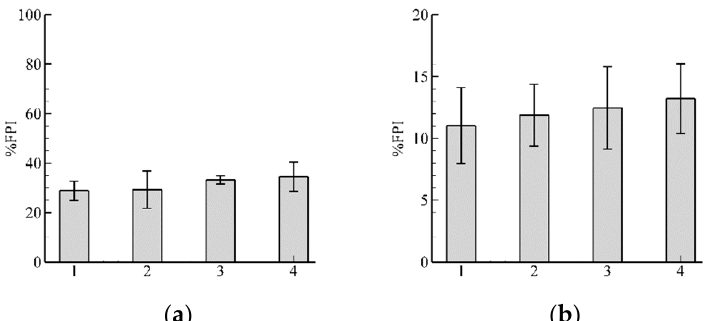
Figure 9. Results of %FPI for two di ff erent flow discharges: ( a ) Inflow U 0 = 0.2 m/s; ( b ) U 0 = 0.3 m/s. Results with U 0 = 0.4 m/s leads to an almost complete blockage of fish passage ( % FPI < 1% ), and does not show here. Note that % FPI scales for ( a , b ) are di ff erent and Equal to 100% and 20%, respectively.